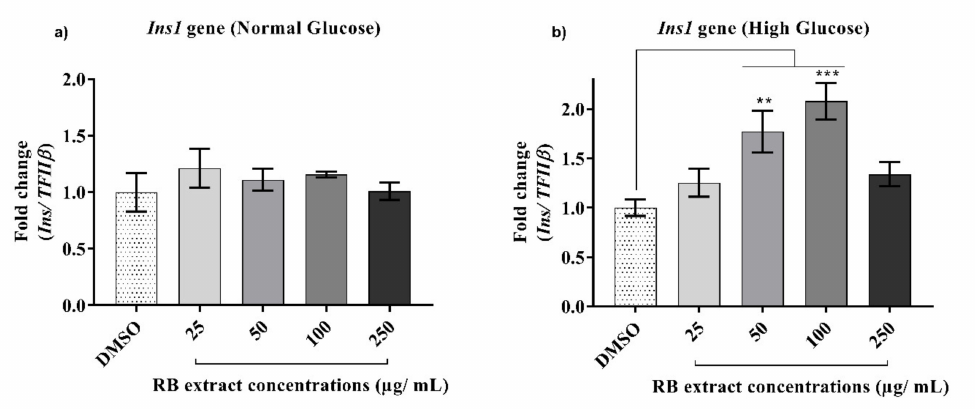
Figure 6. E ff ect of RB phenolic extracts on the expression of the Ins1 gene under normal and high glucose conditions in INS-1E cells. ( a ) Normal glucose conditions, ( b ) High glucose conditions (n = 5). The level of significance is indicated by the asterisks, whereby ** p < 0.01, *** p < 0.001. Data are presented as Mean ± SD. Dimethyl sulfoxide, DMSO; Insulin 1, Ins1 ; Insulin-secreting rat insulinoma cell, INS-1E; Rice bran, RB.